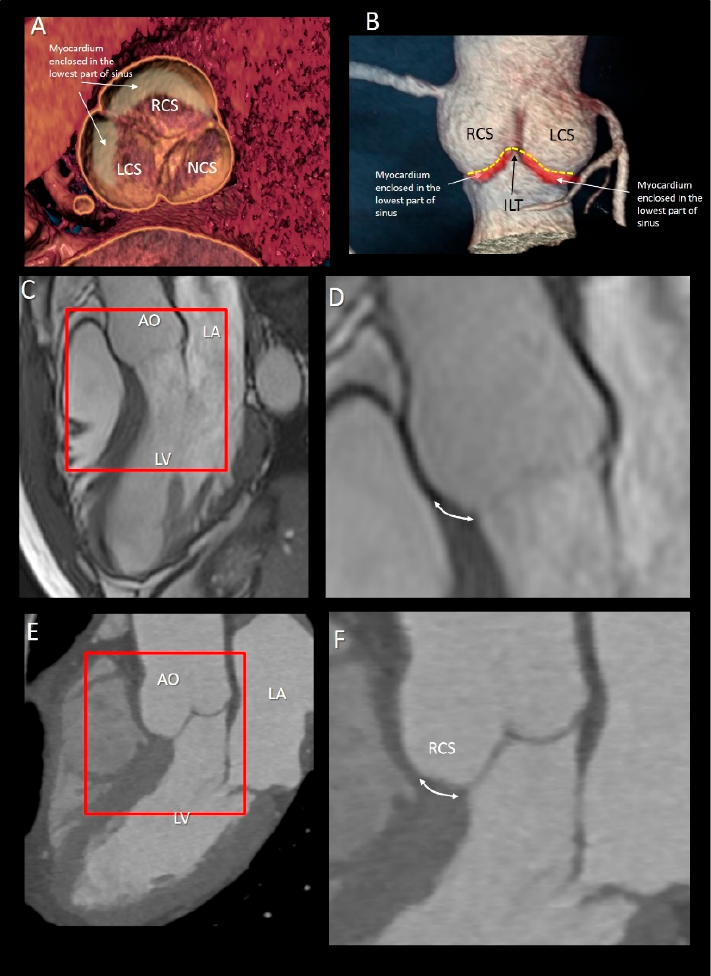
Figure 2. ( A ) CT image of short-axis view of the aortic root from an aortic perspective. The gray-beige areas superimposed to the image indicate the myocardium enclosed at the bases of right coronary sinus (RCS) and left coronary sinus (LCS). ( B ) CT scan of volumetric image of the aortic root. The ventriculo–arterial junction is indicated by the yellow dotted line. The red areas below indicate the muscular myocardium enclosed in the bottom part of the sinuses. ( C ) Cardiac magnetic resonance showing the left ventricle (LV), the left atrium (LA), and the aorta (AO) in cross-section long-axis view. ( D ) Magnified image of the structures in the red square of the panel C. The double-headed arrow marks the extension of muscular sleeve on the right coronary sinus (RCS). ( E ) Computed tomography showing the LV, the LA, and the AO in cross section long-axis view. ( F ) Magnified image of the structures in the red square of the panel C. The double-headed arrow marks the extension of muscular sleeve on the RCS.